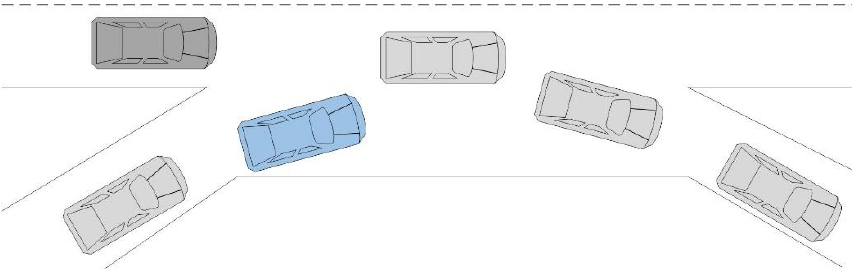
Figure 13. The interweaving area.